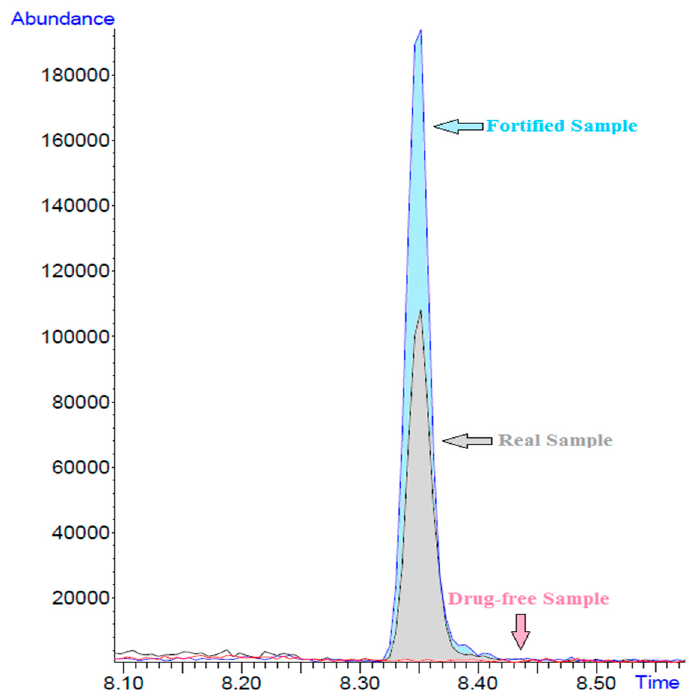
Figure 3. Overlayed extracted ion chromatograms of a real, fortified and drug-free sample.